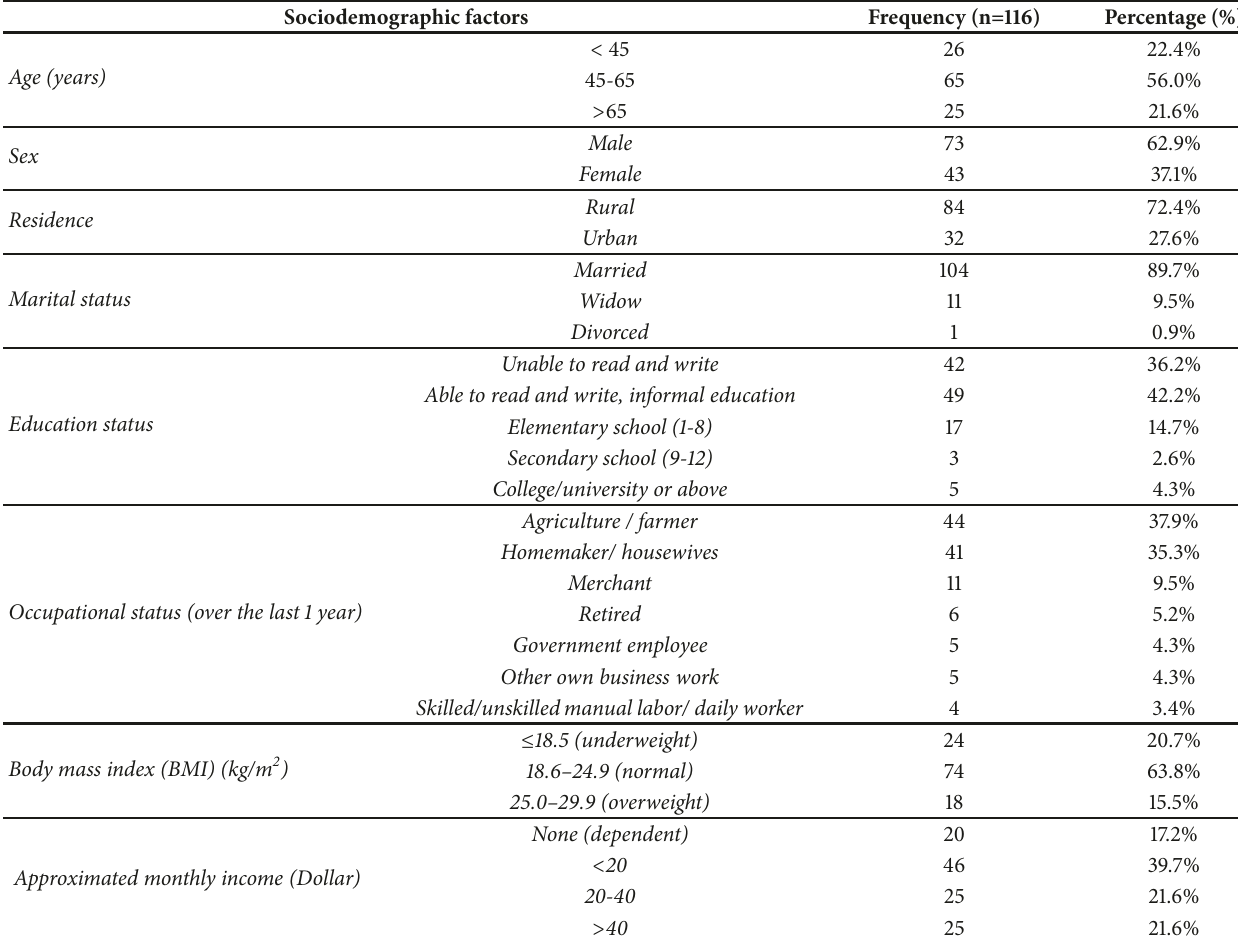
Table 1: Sociodemographic characteristics of stroke among adult patients admitted to stroke unit of JUMC from March 10 to July 10, 2017. Sociodemographic